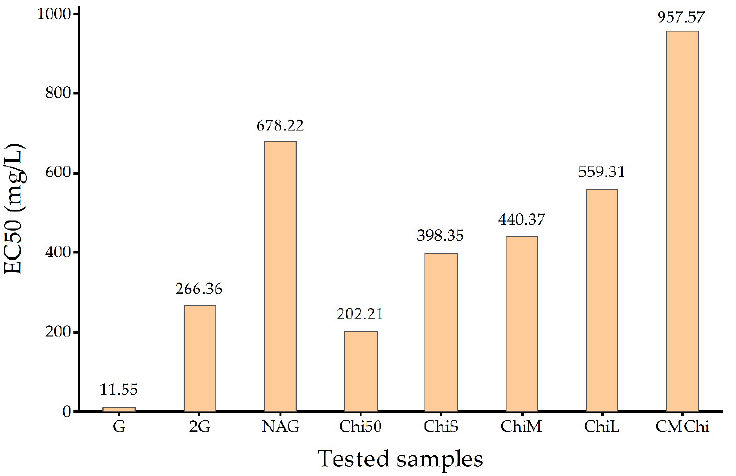
Figure 3. Comparison of EC 50 values of tested chitooligosaccharides, chitosan and their